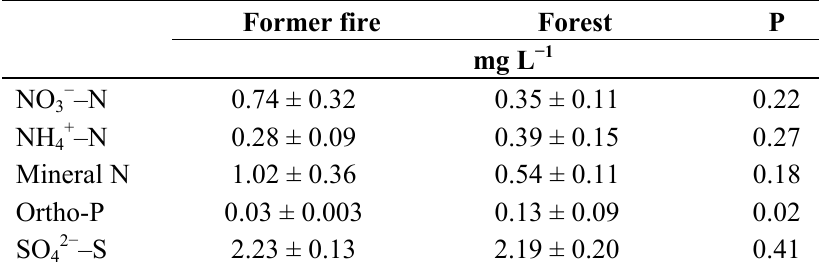
Table 4. Soil solution concentrations (averages and standard errors) from ceramic cup lysimeters collected in April 2007. Probabilities of differences between sites from Student’s t -tests were conducted on log transformed values are shown.